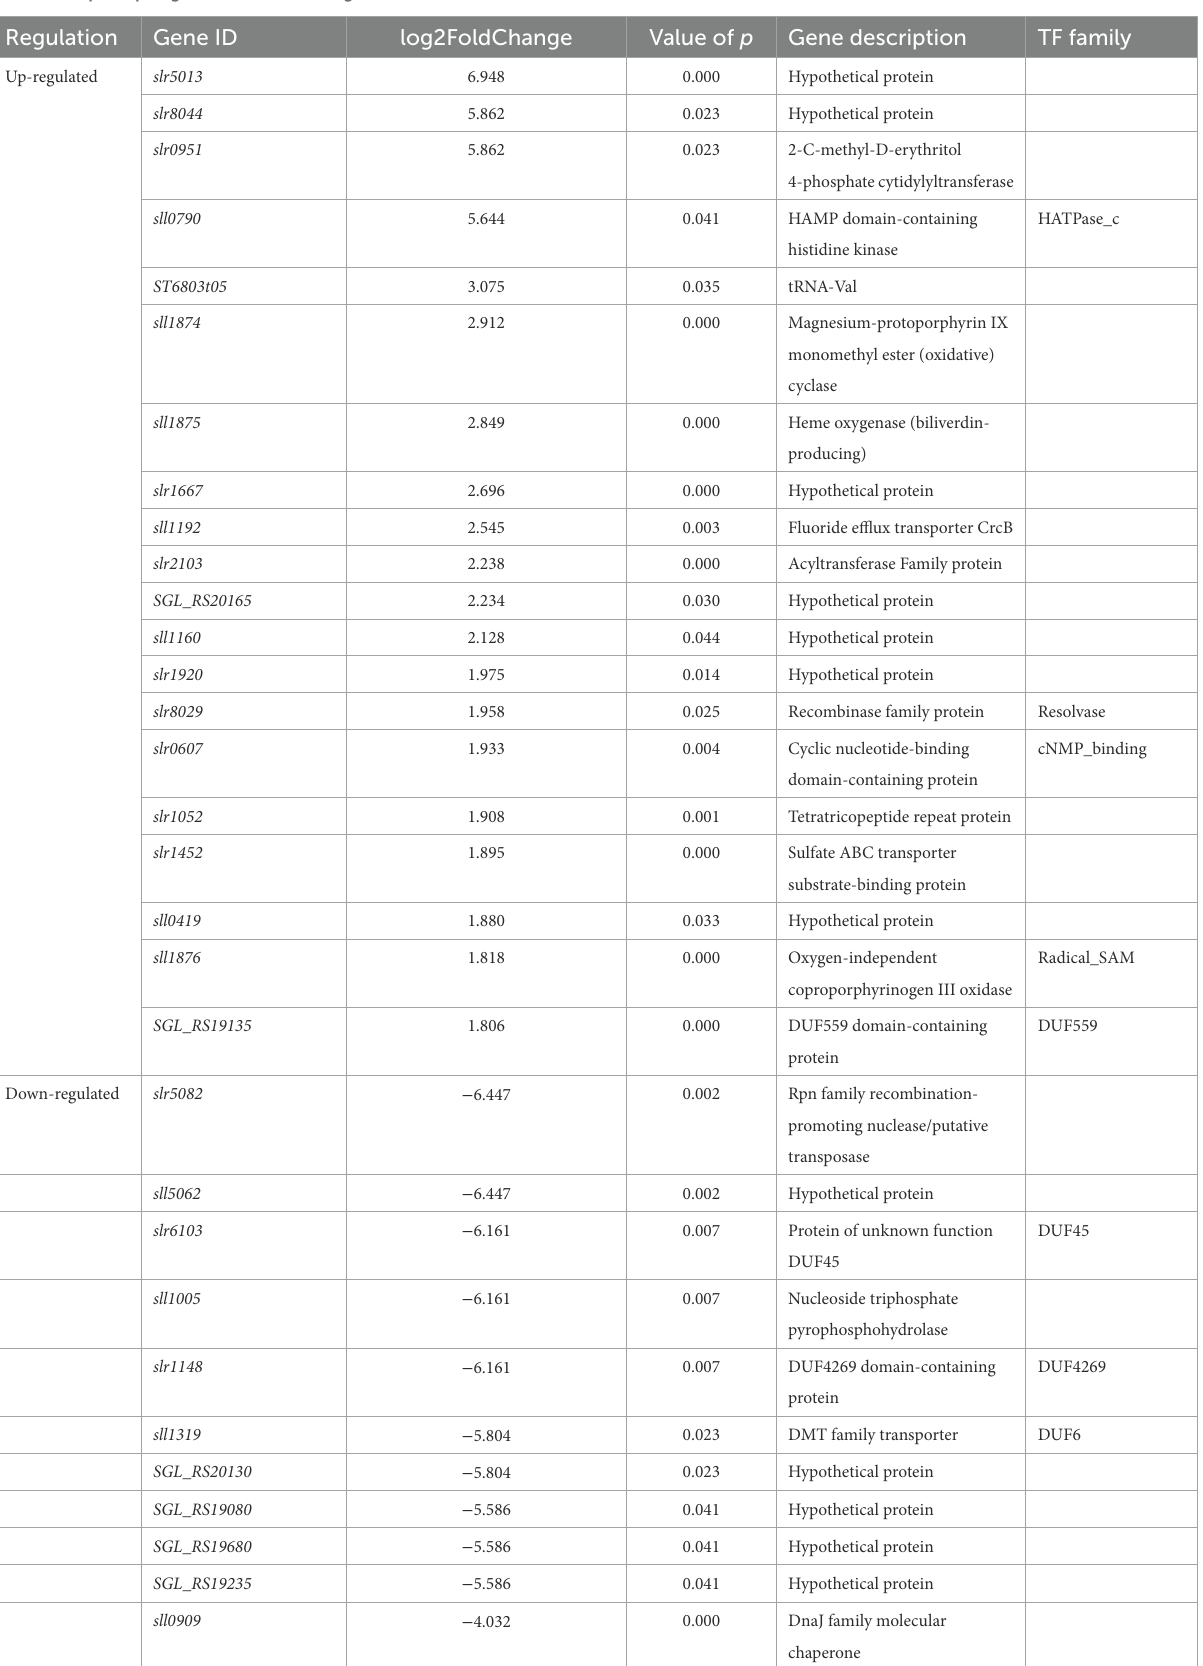
TABLE 4 Top20 up-regulated and down-regulated DEGs in